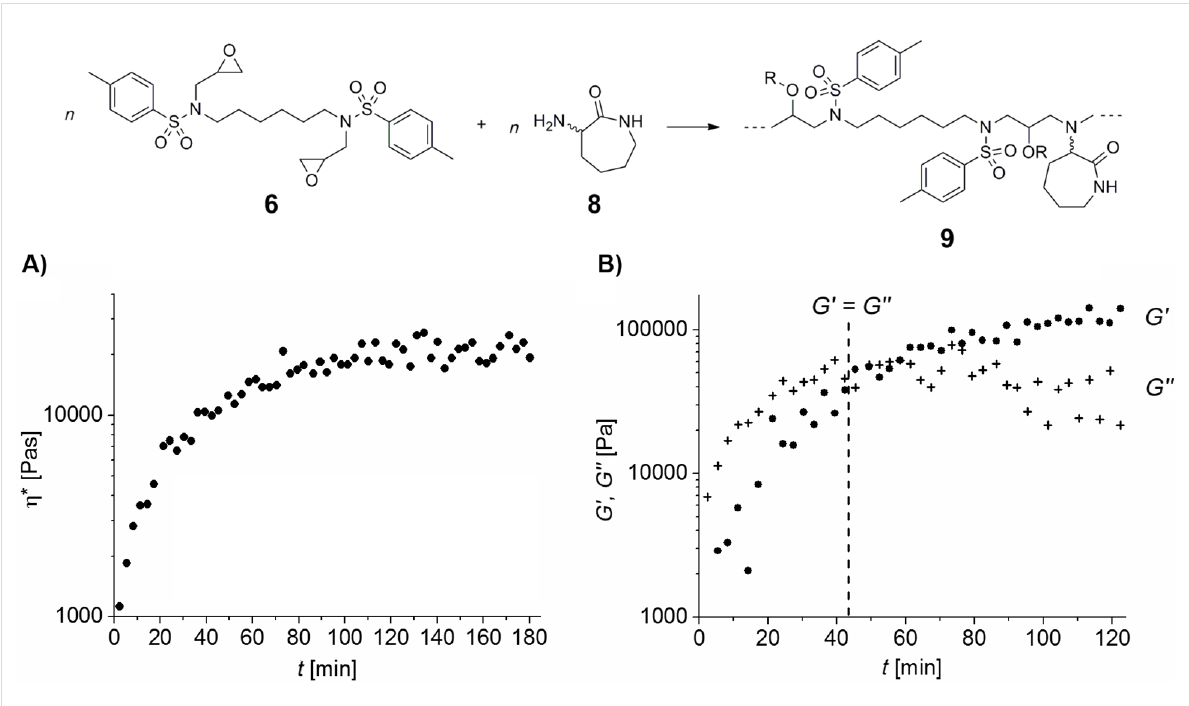
Figure 2: Oscillatory rheological measurements of an equimolar mixture of 6 and 8 at 50 °C. Illustrated is the complex viscosity (A), as well as G’ and G’’ (B) in dependence of time. The polymer 9 is displayed as an idealized structure (R = H or polymer network; crosslinking via addition of epoxide moieties to the hydroxy functions is likely